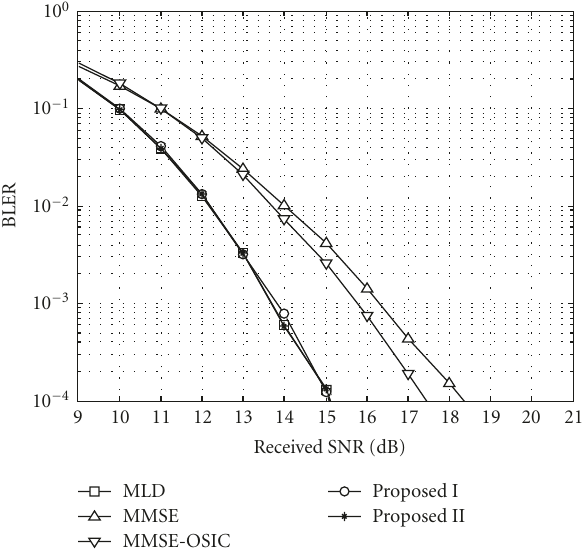
Figure 6: Comparison of the BLER performance of the first PSS for the proposed and the conventional schemes when both MSs transmit with (QPSK, 1/2).